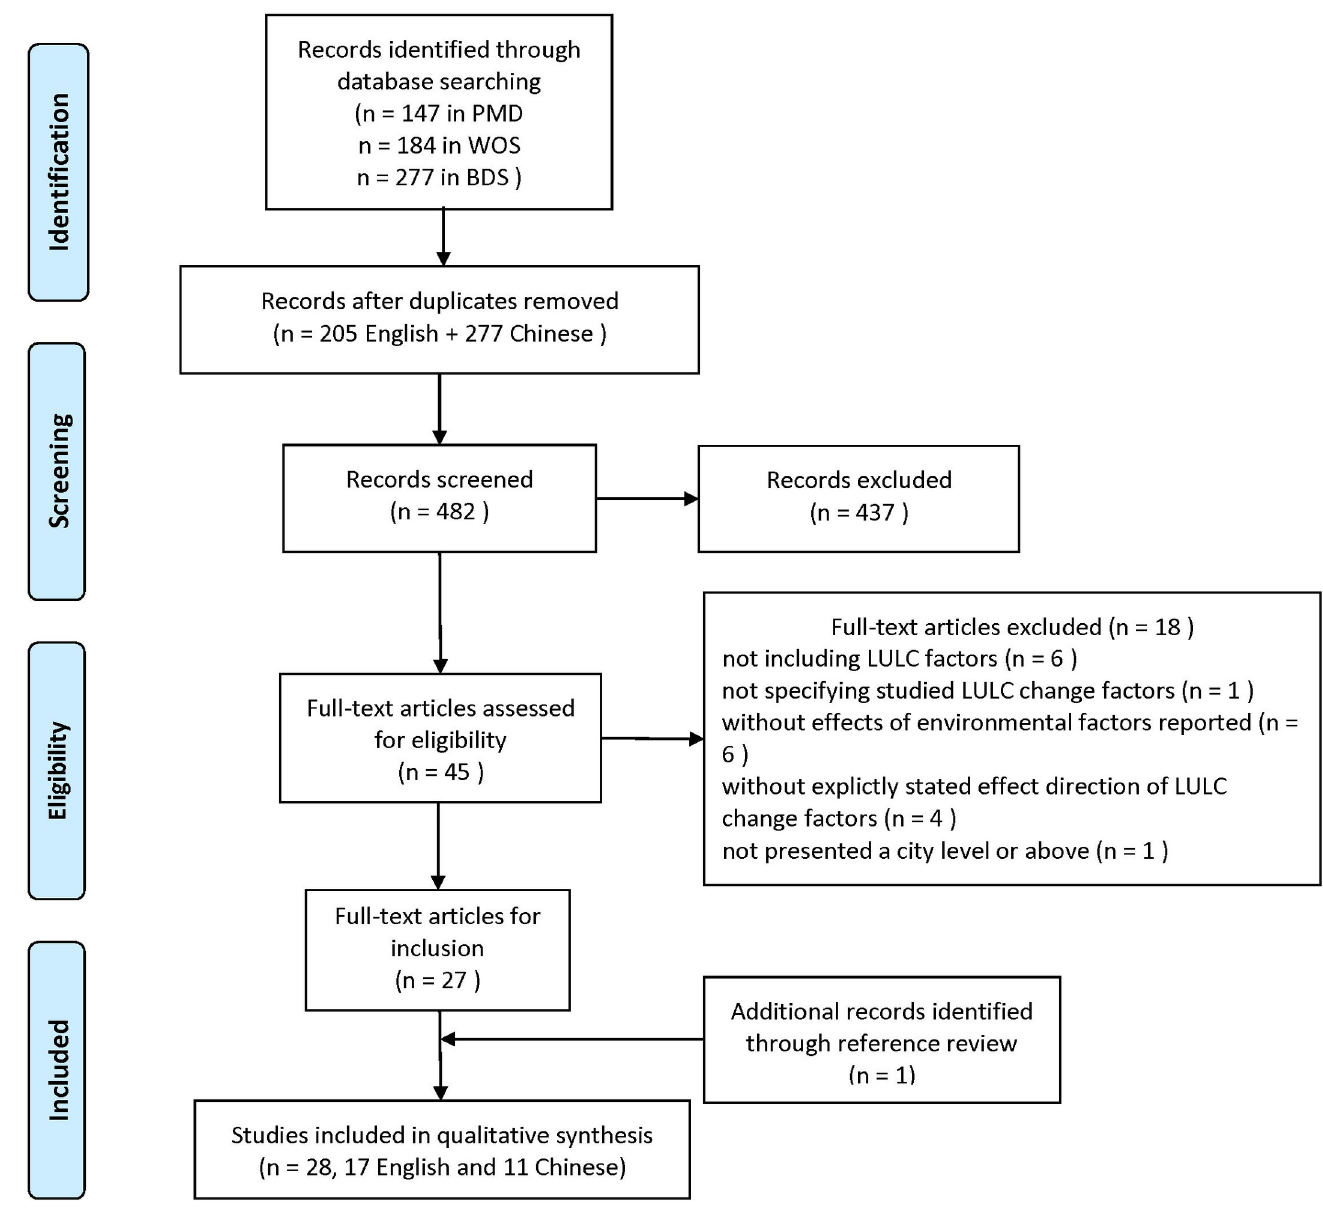
Fig 1. PRISMA flow diagram of the article selection